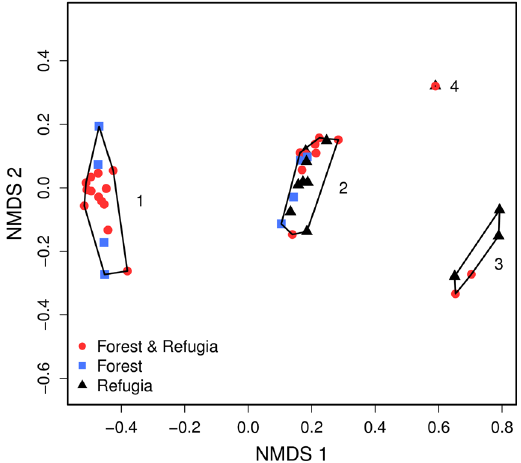
Figure 4. NMDS ordination of 37 tree species based on Bray–Curtis species similarity coefficients for six functional traits. Axis 1 is a combination of dispersal mode and the capacity to resprout. Three clear groups were identified: Group 1 (n = 18): bird dispersed non-sprouters; Group 2 (n = 20): bird-dispersed resprouters; Group 3 (n = 5) wind-dispersed resprouters. Cussonia spp. (4) are bird dispersed resprouters characterised by low WD, low SLA and thick bark compared with species assigned to group 2. Forest & Refugia: species recorded from forest and refuge sites; Forest: species recorded from forest only; Refugia: species recorded from refuge sites only. Stress = 0.065.